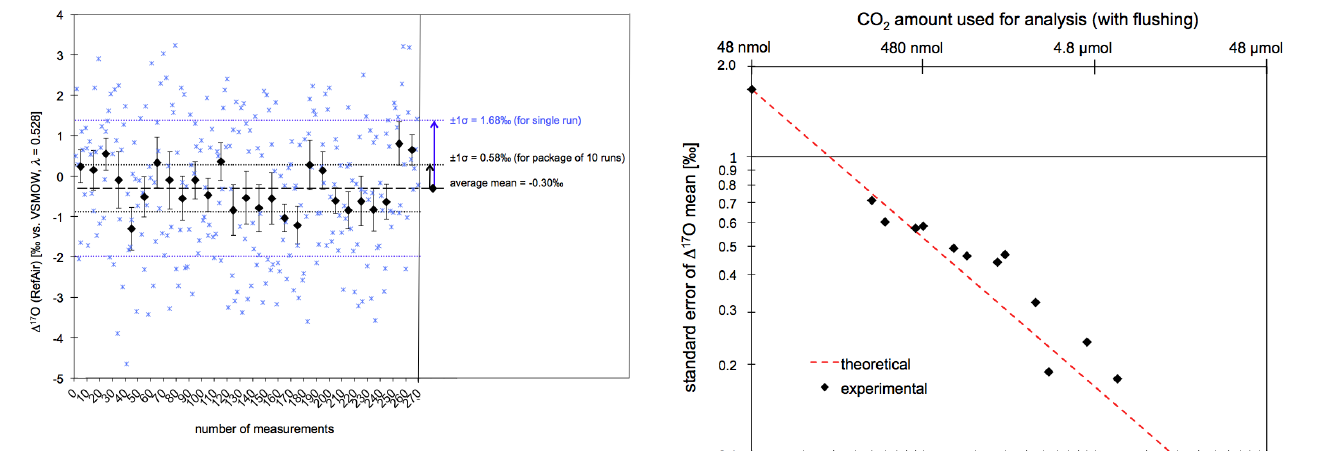
Figure 6. Stability and reproducibility test for the analytical sys- tem: (cid:49) 17 O values of reference air were measured constantly for several days. Striped black line indicates the average value of 270 runs and for 27 groups of 10 measurements respectively. The dotted lines indicate standard deviation over 270 individual runs (blue) and over 27 groups of 10 measurements (black) and show how multiple measurements on the same sample decrease the measurement error.